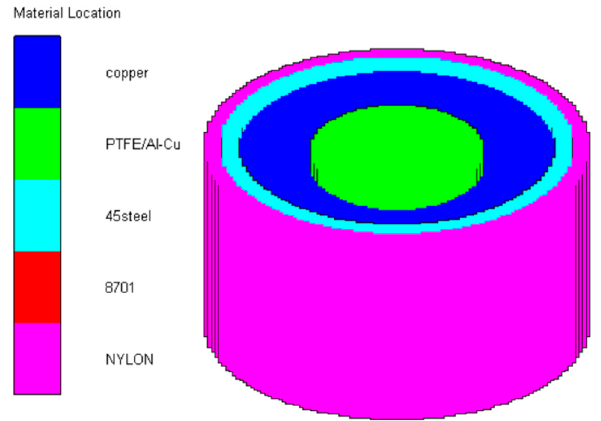
Figure 4. Numerical model of reactive EFP.